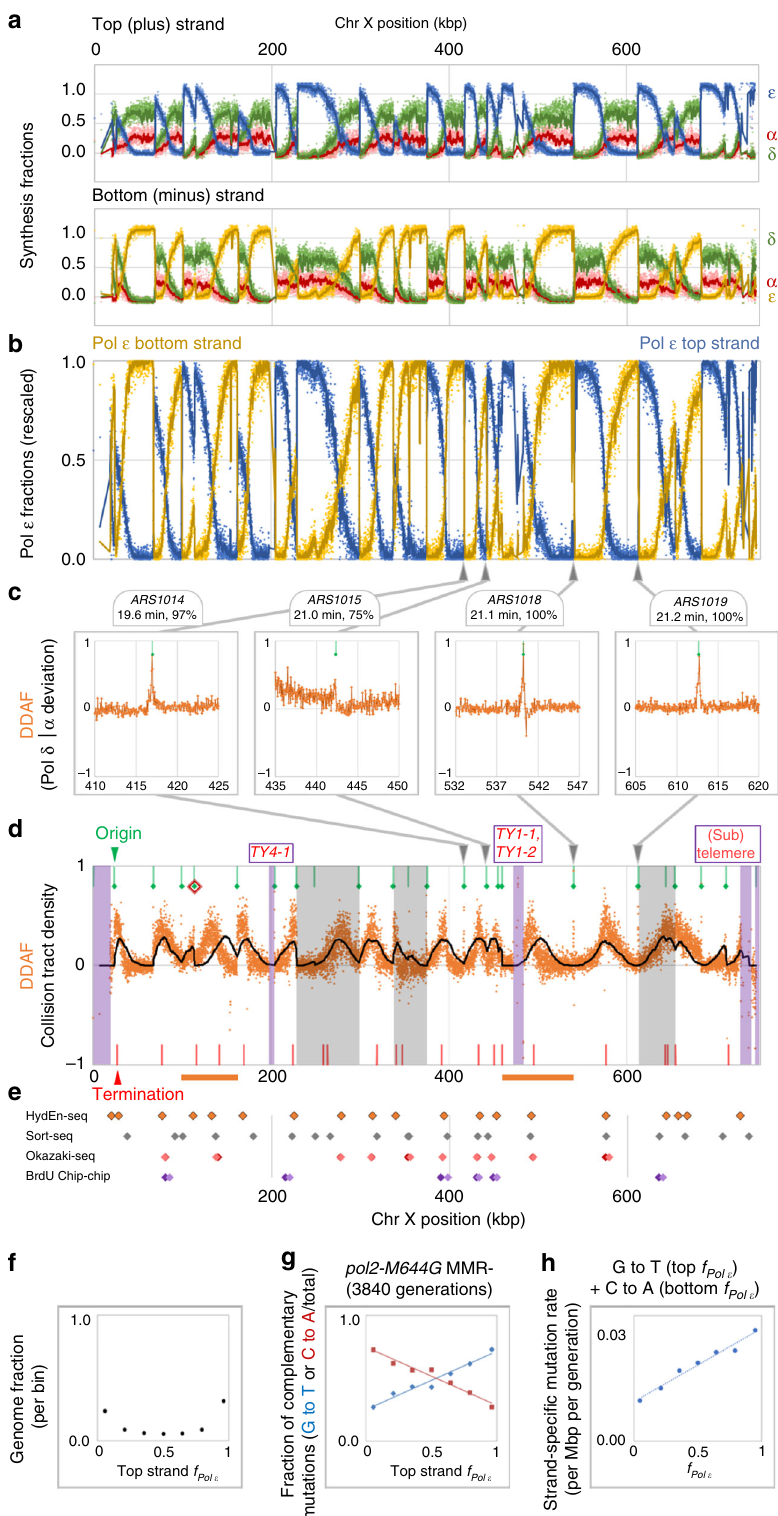
Pol δ conducts a signi fi cant portion of leading strand synthesis in S. cerevisiae . We fi rst performed RHII-HydEn-seq in S. cere- visiae RER-de fi cient strains. Replication origins were identi fi ed as abrupt shifts in the polymerase synthesis fractions on both strands (Pols ε in Fig. 2b). Importantly, the lower background noise of RHII-HydEn-seq allows higher sensitivity and